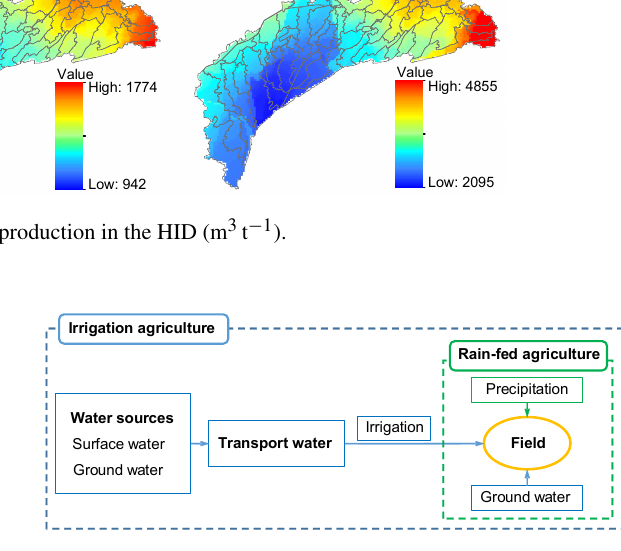
Figure 10. Irrigation agriculture and rain-fed